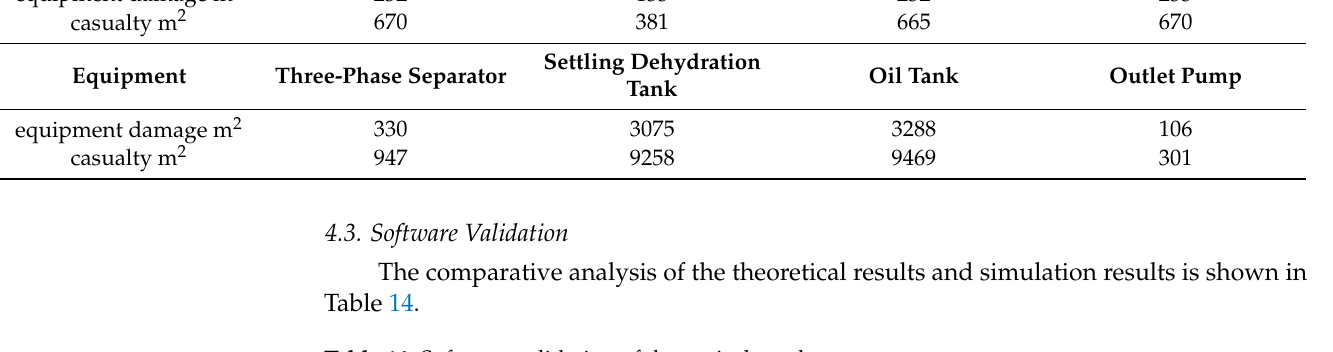
Table 14. Software validation of theoretical